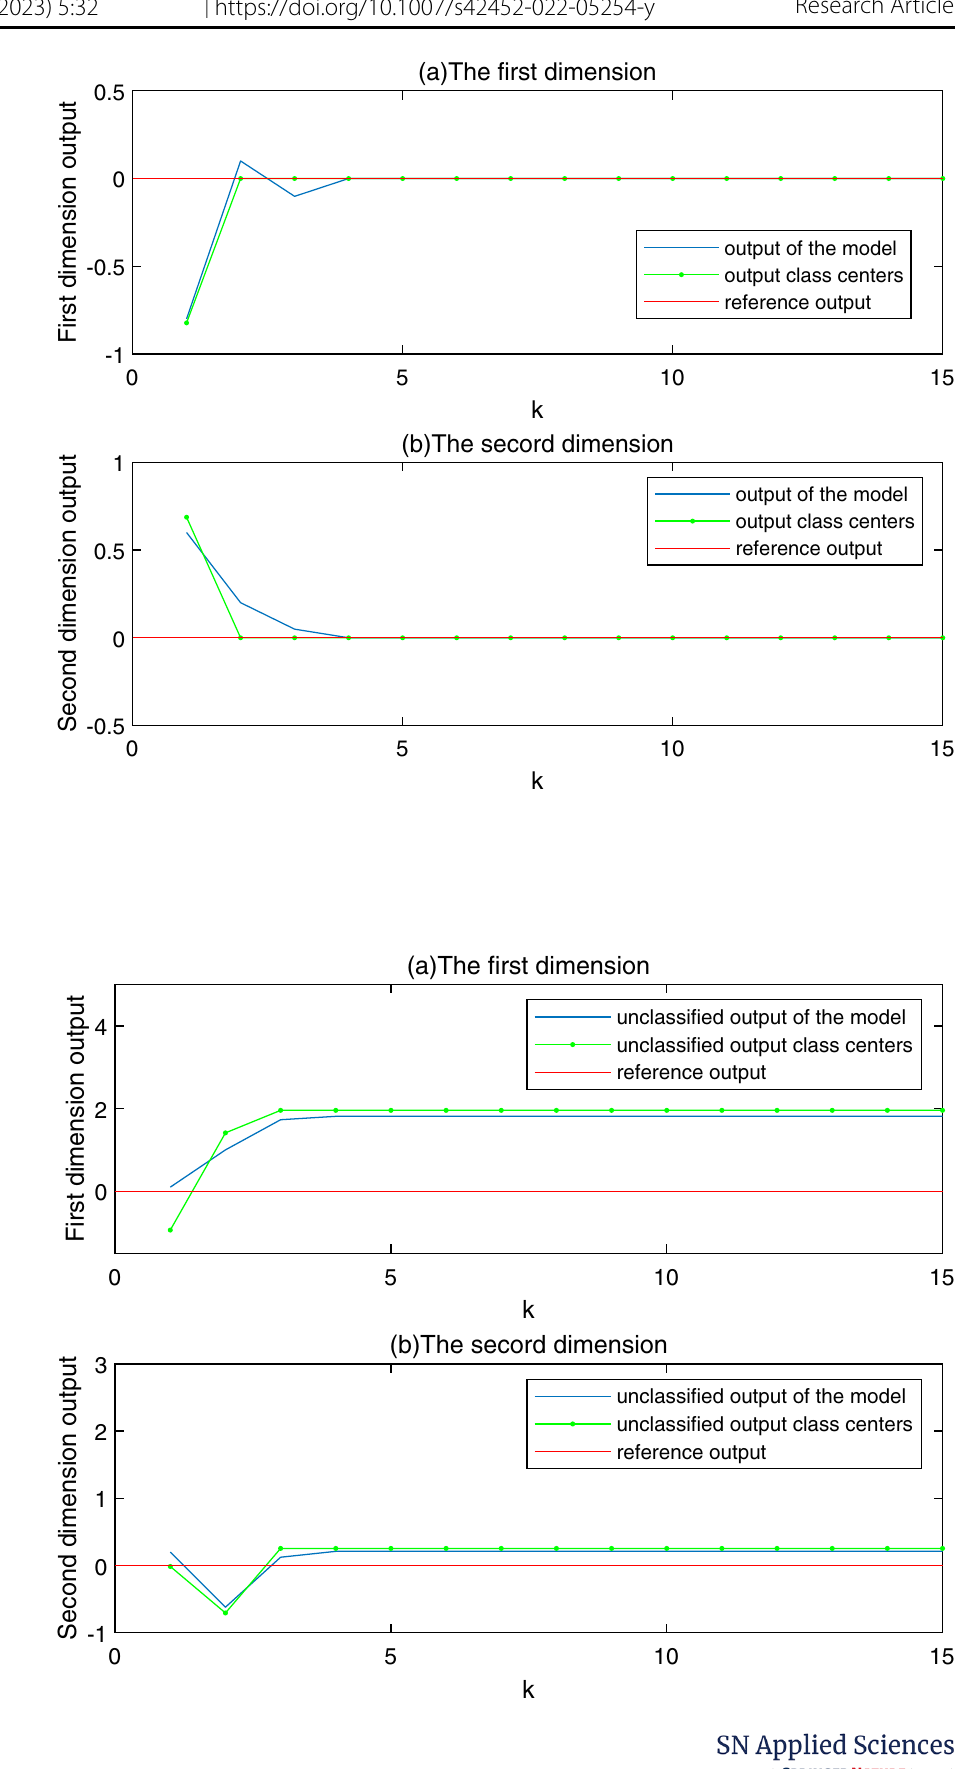
Fig. 9 System output curves of burning processes before